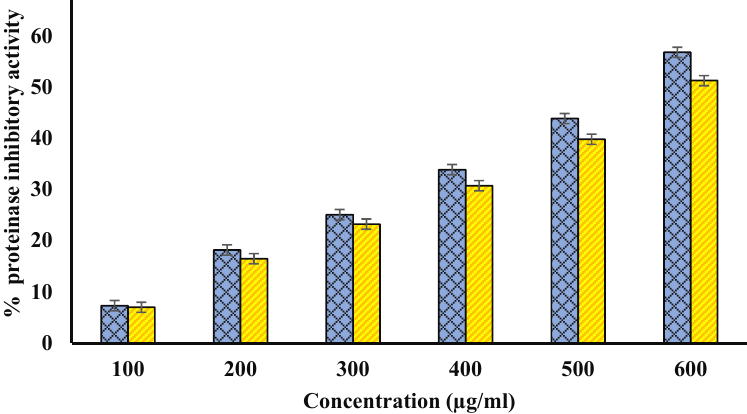
Figure 5. Percentage of proteinase inhibitory activity. Blue bars show percentage of proteinase inhibitory activity plot for various concentrations ( µ g/mL) of fruit pulp. However, yellow columns show the percentage of proteinase inhibitory activity plot for various concentrations ( µ g/mL) of seed extract. The p -value significance was found to be less than 0.05 for this figure ( p < 0.05).